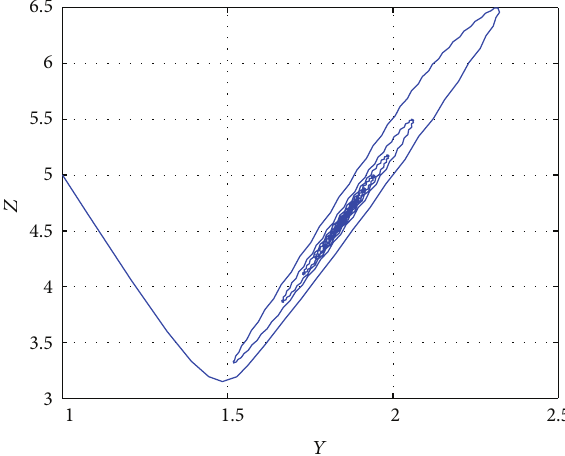
Figure 5: 𝑌𝑍 -plane projection of the solution for nonzero exoge- nous input ( 𝛾 = 1.25 ) with 𝑋(0) = 1 , 𝑌(0) = 1 , and 𝑍(0) = 5 ; parameter values are given in Table